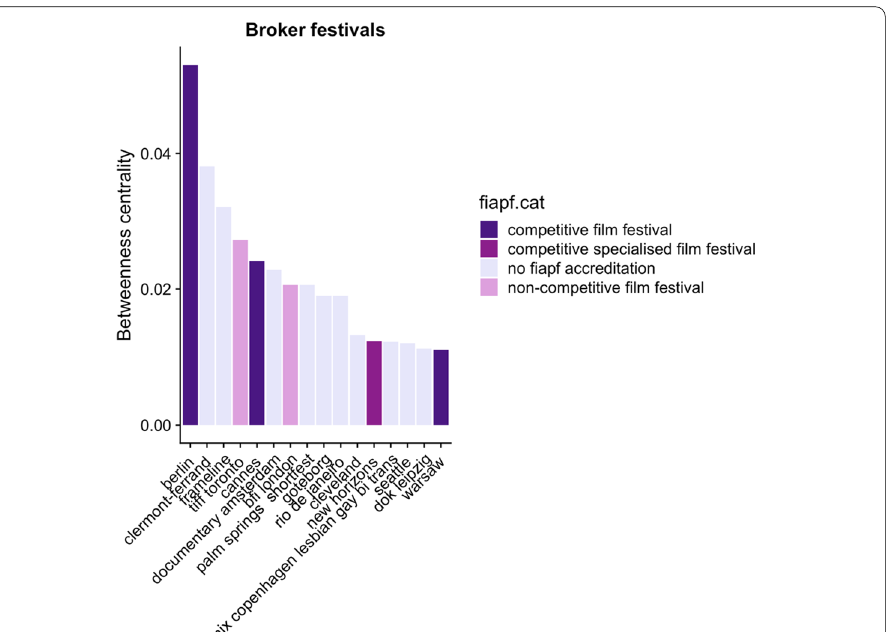
Fig. 4 Broker festivals based on top 99 percentile in distribution of betweenness centrality